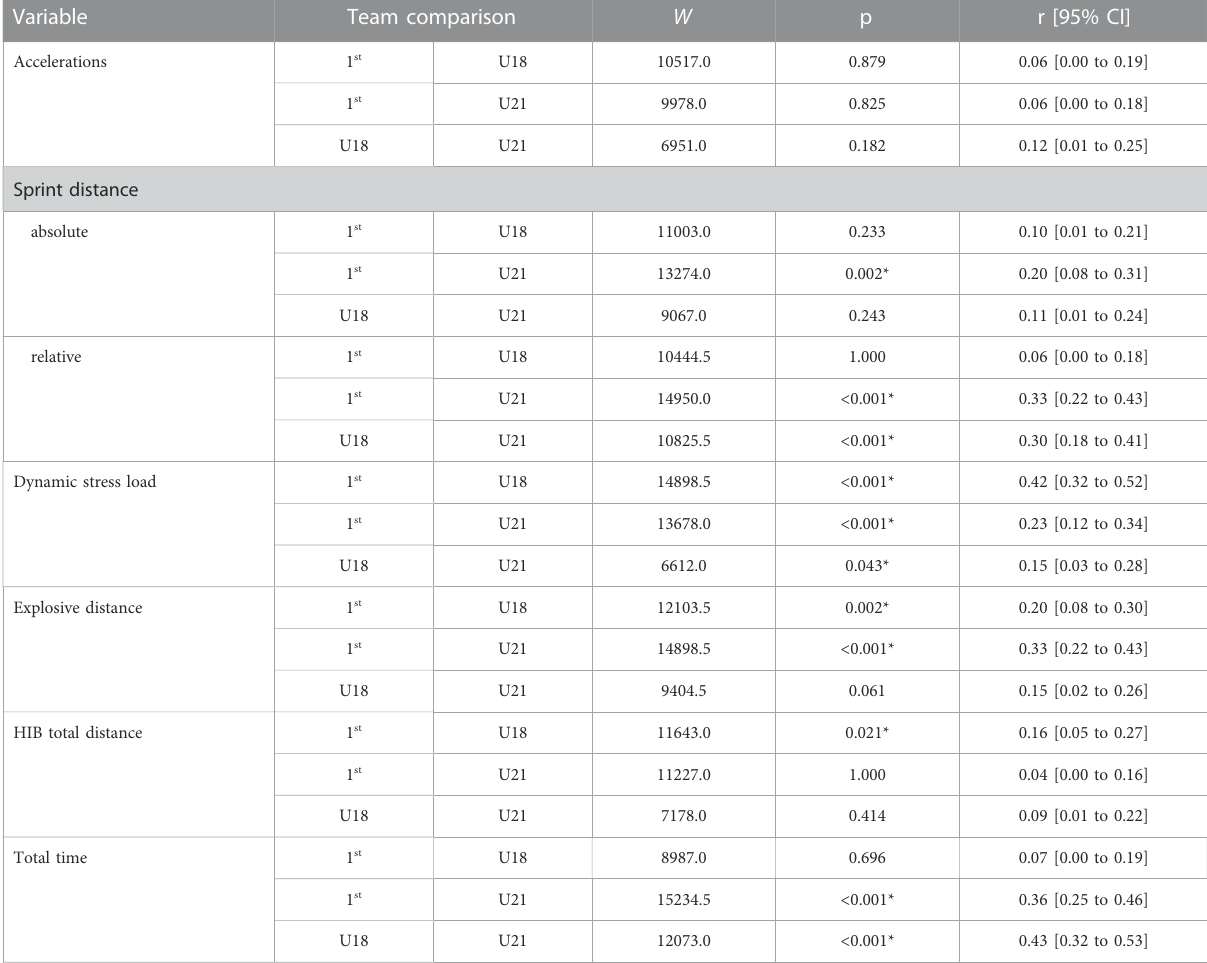
TABLE 9 Wilcoxon rank sum tests (with Bonferroni corrections) comparisons between teams for selected external load measures. Con fi dence level of the r con fi dence intervals = 0.95. Level of signi fi cance: * p < 0.05.